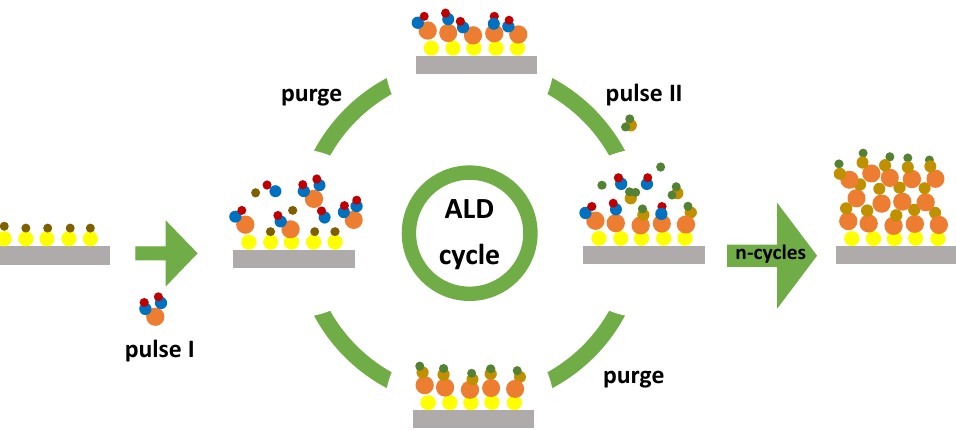
Figure 1. Schematic representation of the atomic layer deposition (ALD) process adapted from O’Neill et al. (2015) [51].